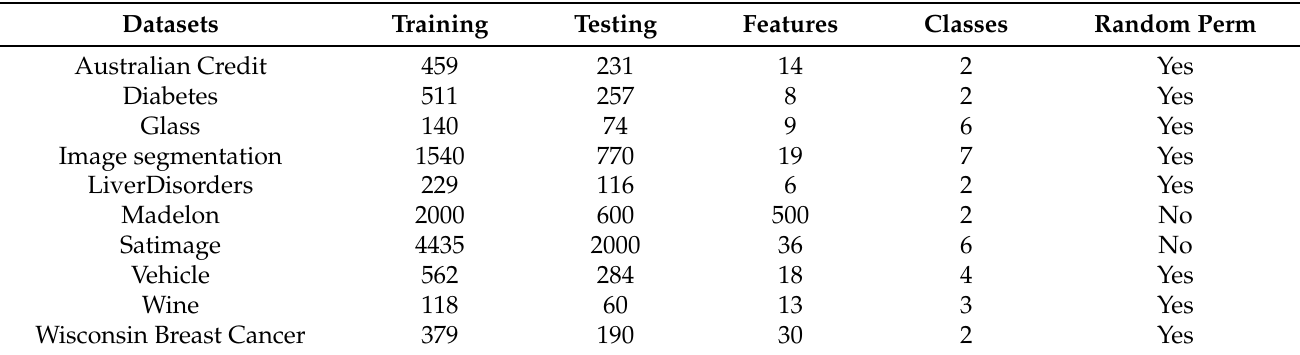
Table 1. UCI Data sets Used in Our Experiments.